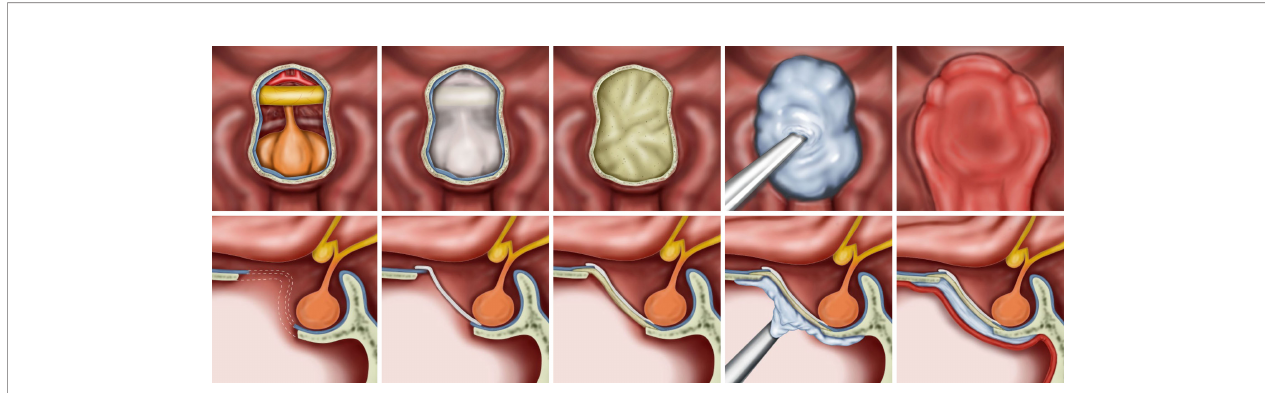
FIGURE 1 | Illustrations for the steps of the multilayer reconstruction technique with hydroxyapatite and a naso-septal fl ap. The collagen matrix is fi rst placed into the arachnoid defect. Then, an acellular dermal graft is laid over as an on-lay dura graft after being tailored according to the size of the bone defect. Injectable hydroxyapatite is applied as an additional closure of the sellar defect. Finally, a naso-septal fl ap covers the above